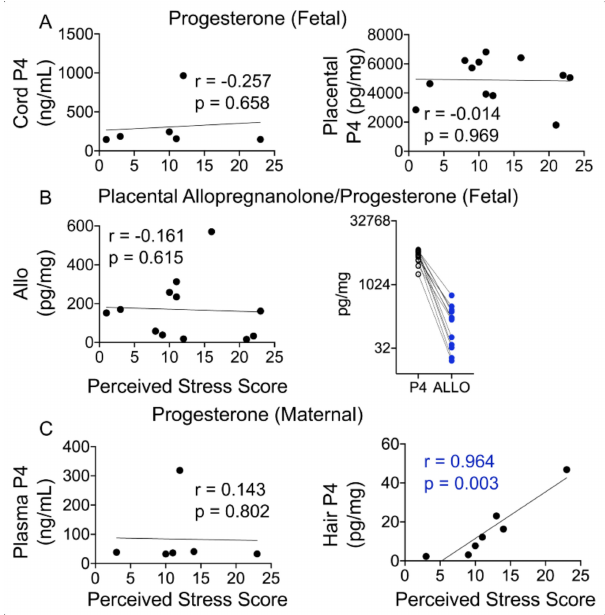
Figure 5. Maternal not fetal progesterone positively correlates with the PSS. ( A ) Cord or placental progesterone levels did not correlate with the maternal PSS. ( B ) Placental ALLO levels also did not correlate with the PSS. Placental progesterone levels were ~29-fold higher than placental ALLO levels, and ALLO levels were lower than P4 in each participant. ( C ) While maternal plasma progesterone levels did not correlate with the PSS, hair P4 levels displayed a significant positive correlation with the PSS ( r = 0.964, p = 0.003). N = 7. Mann–Whitney U test and Spearman’s correlation